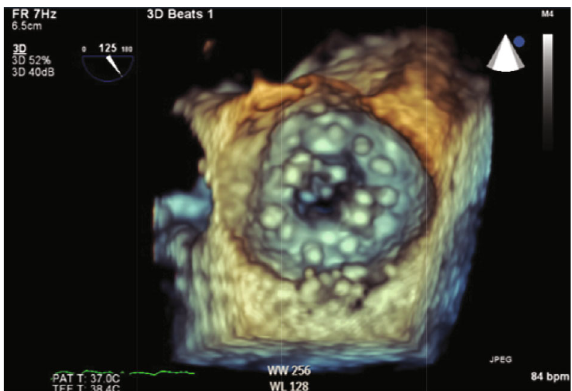
Figure 4: 3D transesophageal echocardiogram of the normally functioning mechanical mitral valve at 125 degrees following treatment with